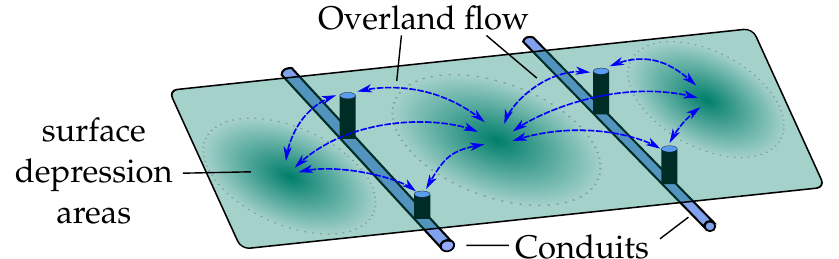
Figure 1. Schematic representation of the 1D1D overland flow modelling. The subareas are marked by the dashed gray circles, with the corresponding storage el- ements in darker green, which are able to exchange water between each other. Additionally, the storage elements can exchange water with open channels or